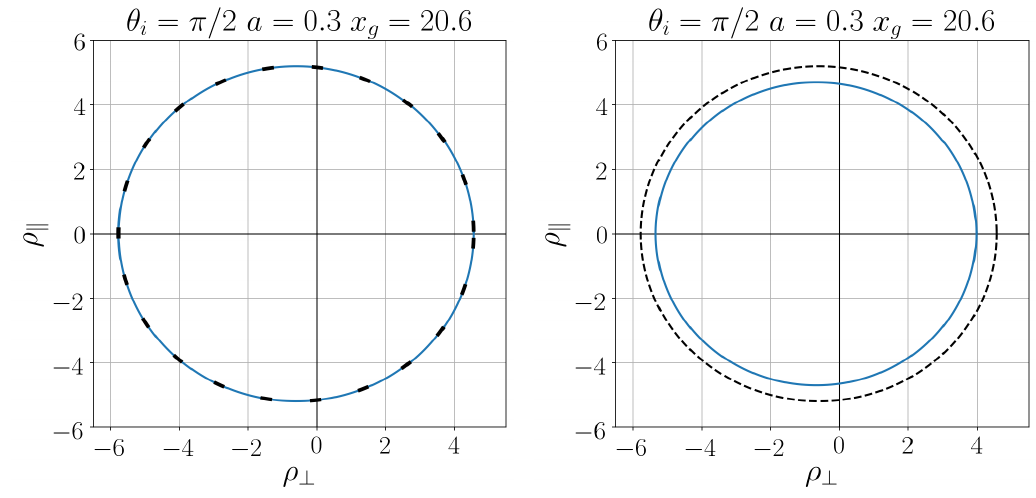
Figure 6. Left : Shadow of the black hole with the polarization profile (56) and of the Kerr black hole (dashed line) for a = 0.3. Right : Shadow of the black hole with the regularized Newtonian profile (58) and of the Kerr black hole (dashed line) for a = 0.3.